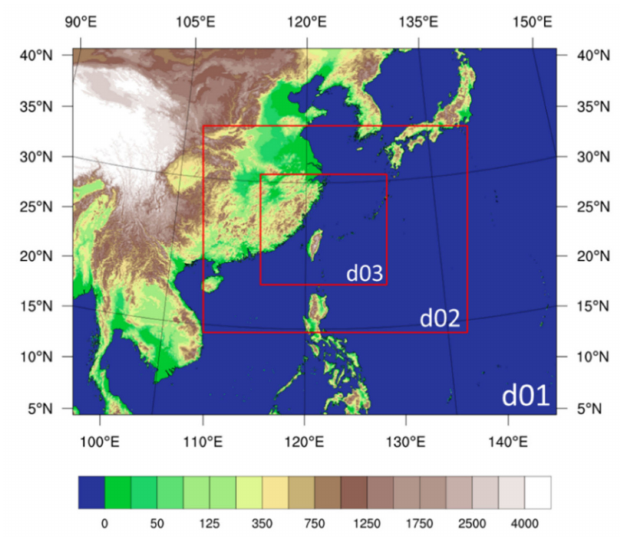
Figure 2. Illustration of domain coverage in D01, D02, and D03. The horizontal resolution was 27, 9, and 3 km in D01 to D03, respectively.